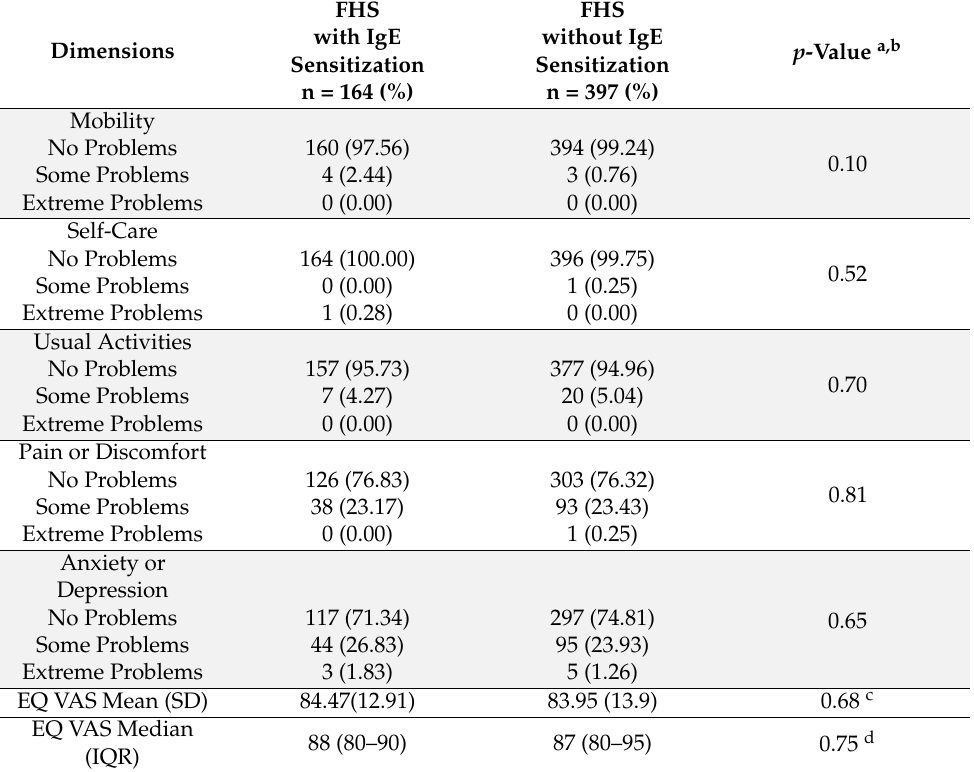
Table 4. Distribution of EQ-5D among adolescents with food hypersensitivity (FHS) in relation to IgE-sensitization (fx5 ®